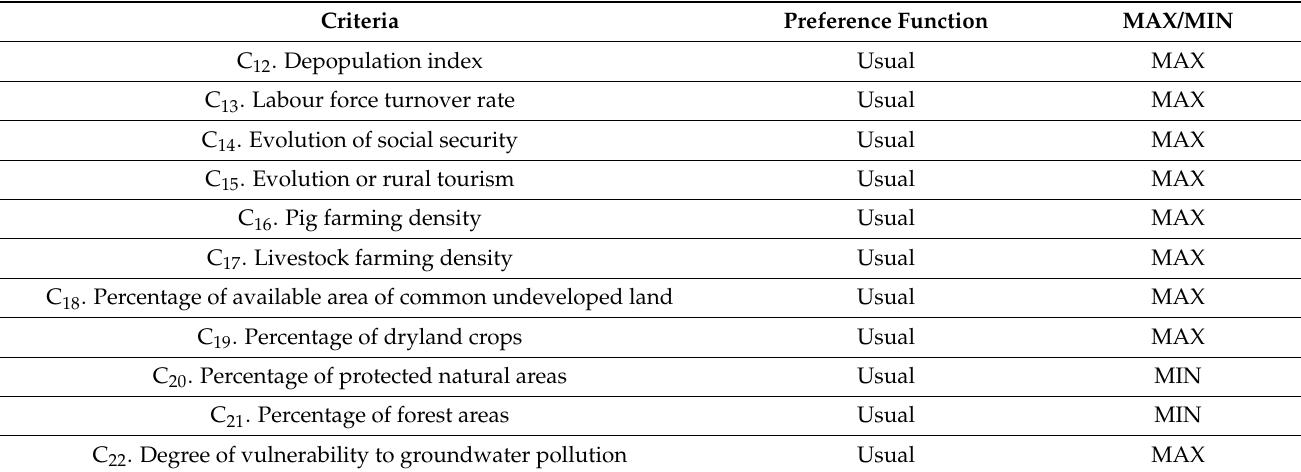
Table 6. Evaluation table of